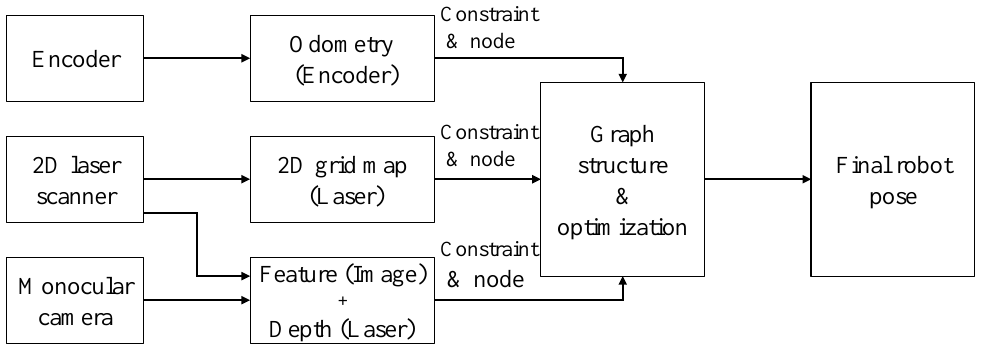
Figure 4. Graph structure generation from respective sensor data. The constraints and nodes are generated from the prediction from each sensor. The final pose of the robot is estimated using graph